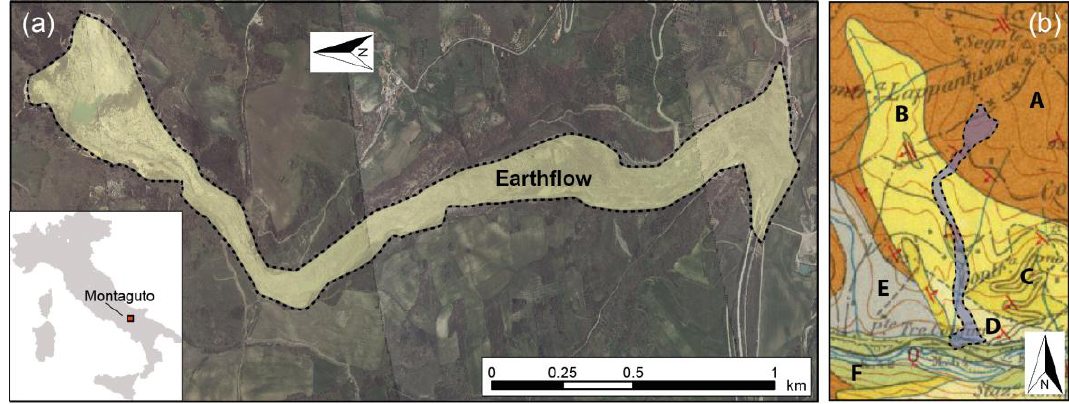
area. A: Flysch formation (Burdig. sup.—Langhiano Inf.); B: Argillaceous marl unit (Messin. Sup.—Plioc. Inf.); C: Arenitic unit (Mess. Inf.); D: Conglomeratic Unit; E: Ligurid unit; F: Alluvial